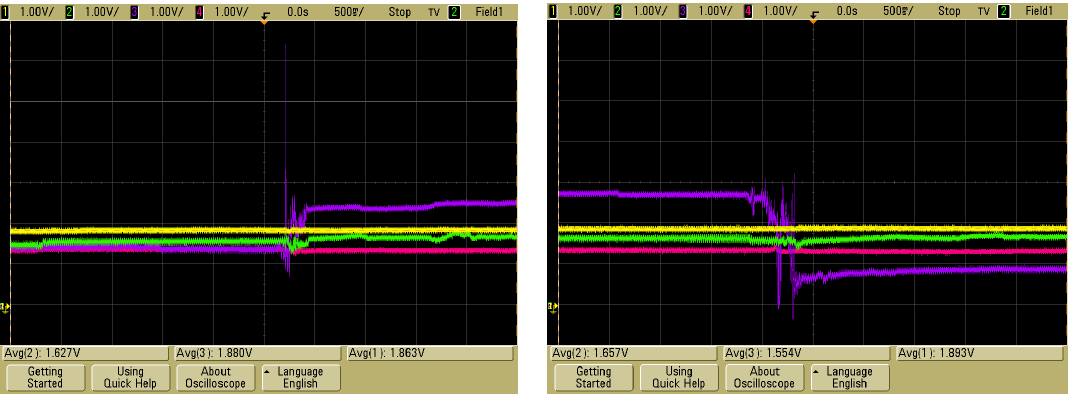
Figure 20. Application of the weights.